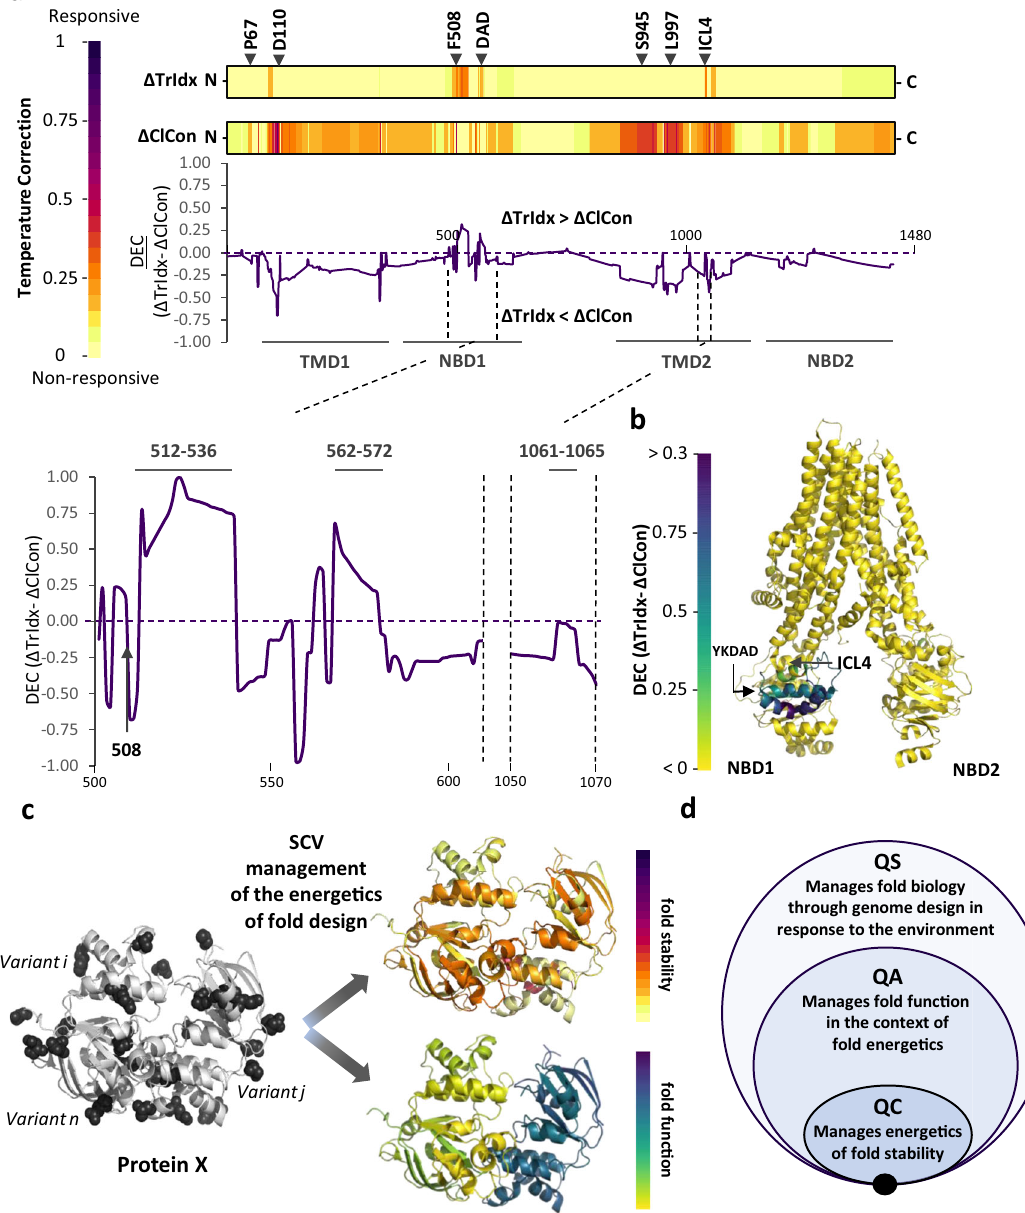
Fig. 6 SCV code scoring global response to folding energetics across the entire CFTR fold. a SCV-based linear code representation of the